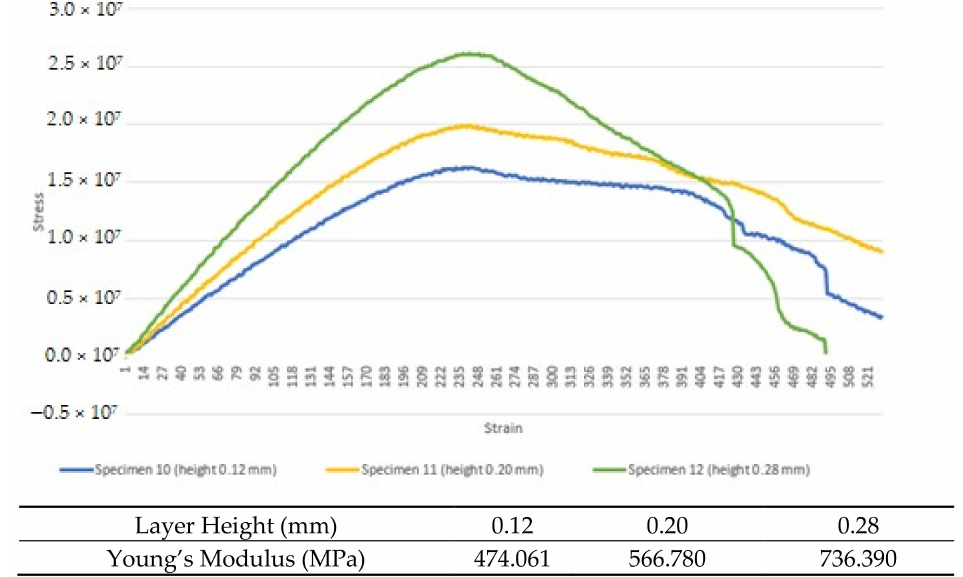
Figure 10. Average experimental stress–strain data for layer height test.